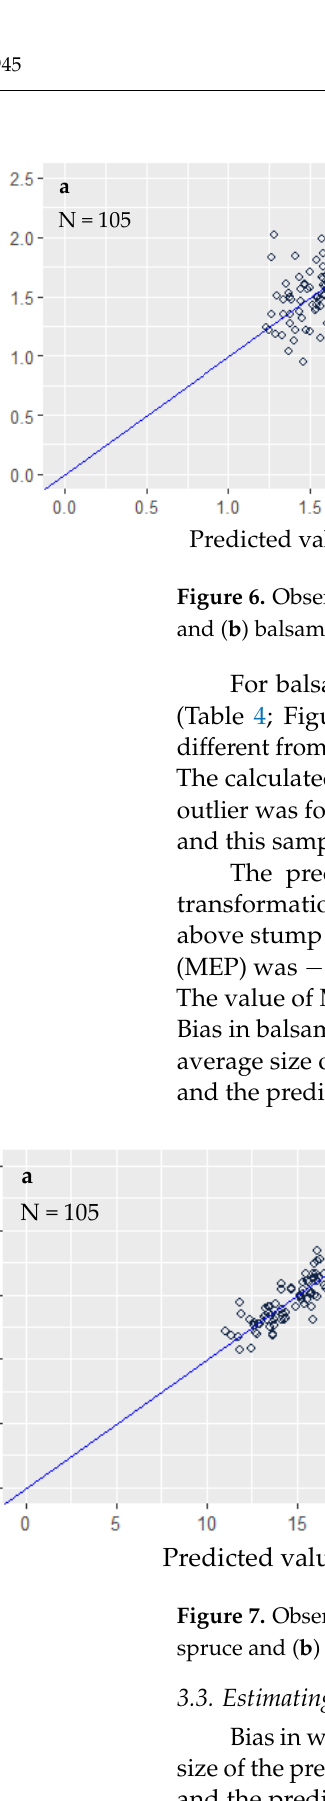
Figure 8. Observed merchantable top length plotted against predicted values with a line of unity for ( a ) white spruce and ( b ) balsam fir. 3.4. Spatialization Tool Outputs of the spatialization tool varied according to the StanForD version. In Stan- ForD, the only output was a shapefile displaying a summary of NUWM per harvest area